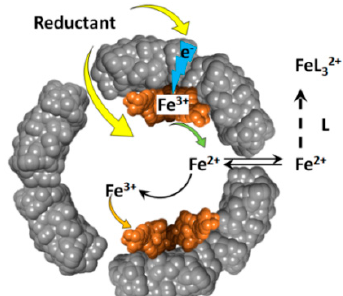
Figure 2. Schematic depiction of the oxidative deposition and reductive mobilization of iron in